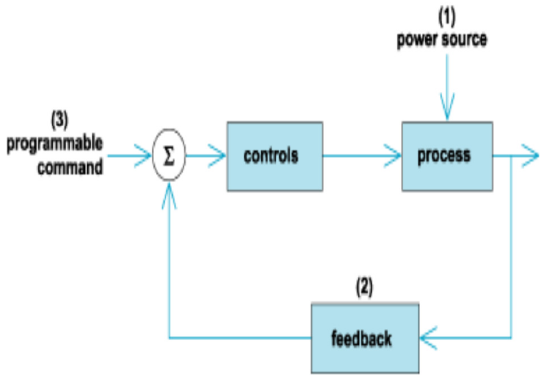
Fig.1. The fundamental constituents of any automated process [ 15]